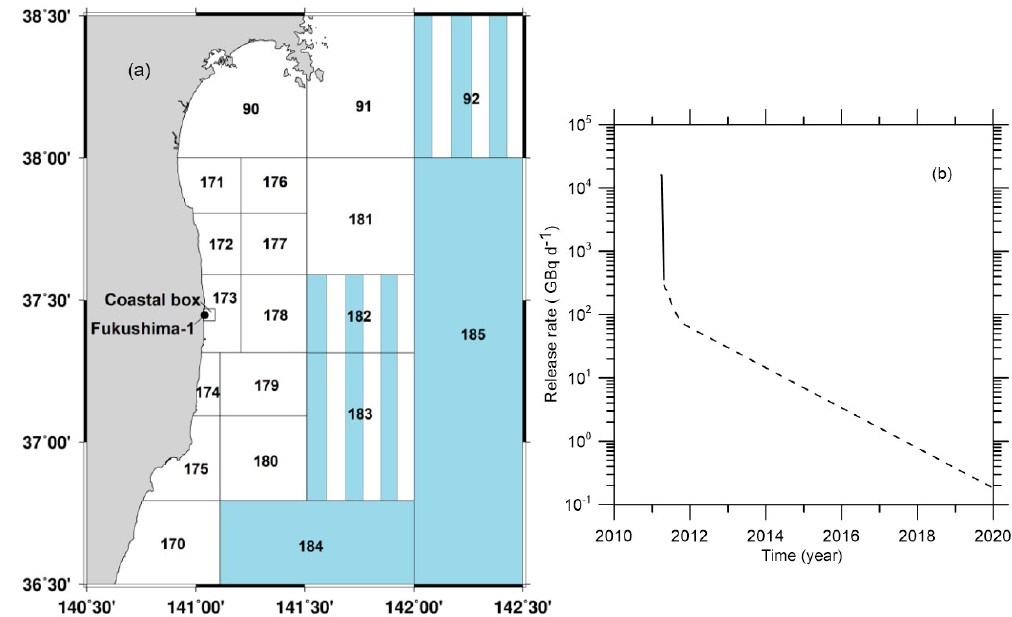
Figure 9. (a) Boxes along the eastern coast of Japan with fine resolution in the area around the FDNPP (Maderich et al., 2018a). Deep boxes with three vertical layers in the water column are coloured by blue, boxes with two vertical layers are marked by vertical stripes, and shallow one-layer boxes are white. (b) Release rates of 90 Sr in the accidental (bold line) and post-accidental (dashed line)